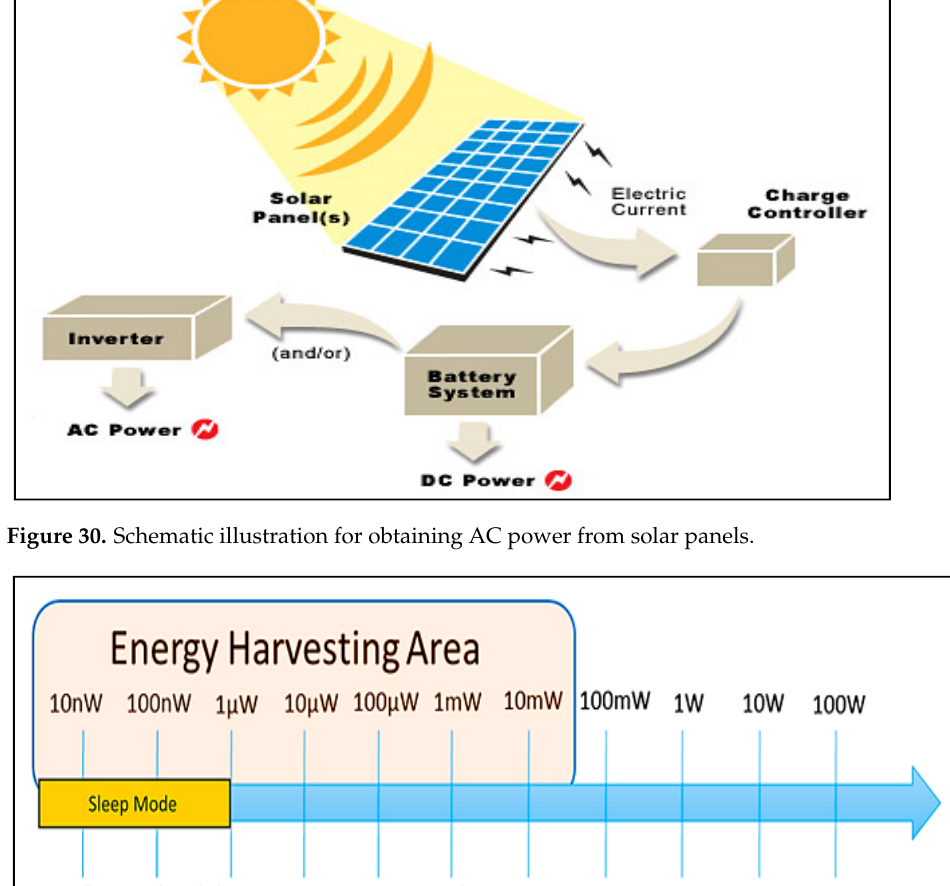
Figure 30. Schematic illustration for obtaining AC power from solar panels.